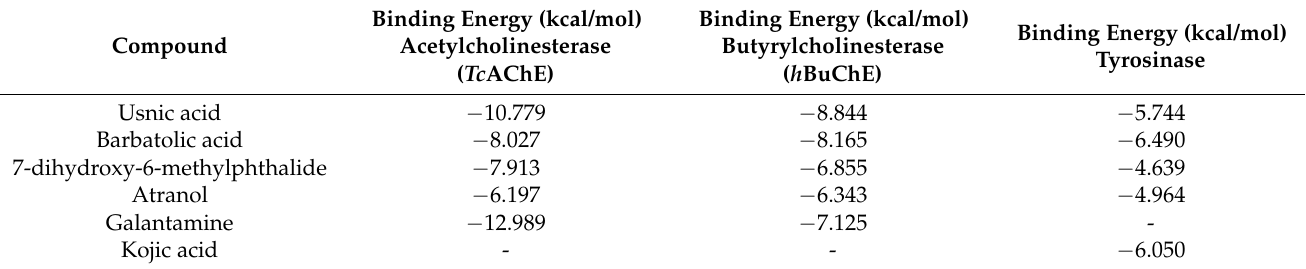
Table 4. Binding energies obtained from docking experiments of selected major compounds in H. lugubris as well as the known inhibitor binding energy galantamine over acetylcholinesterase (TcAChE), butyrylcholinesterase ( h BuChE), and